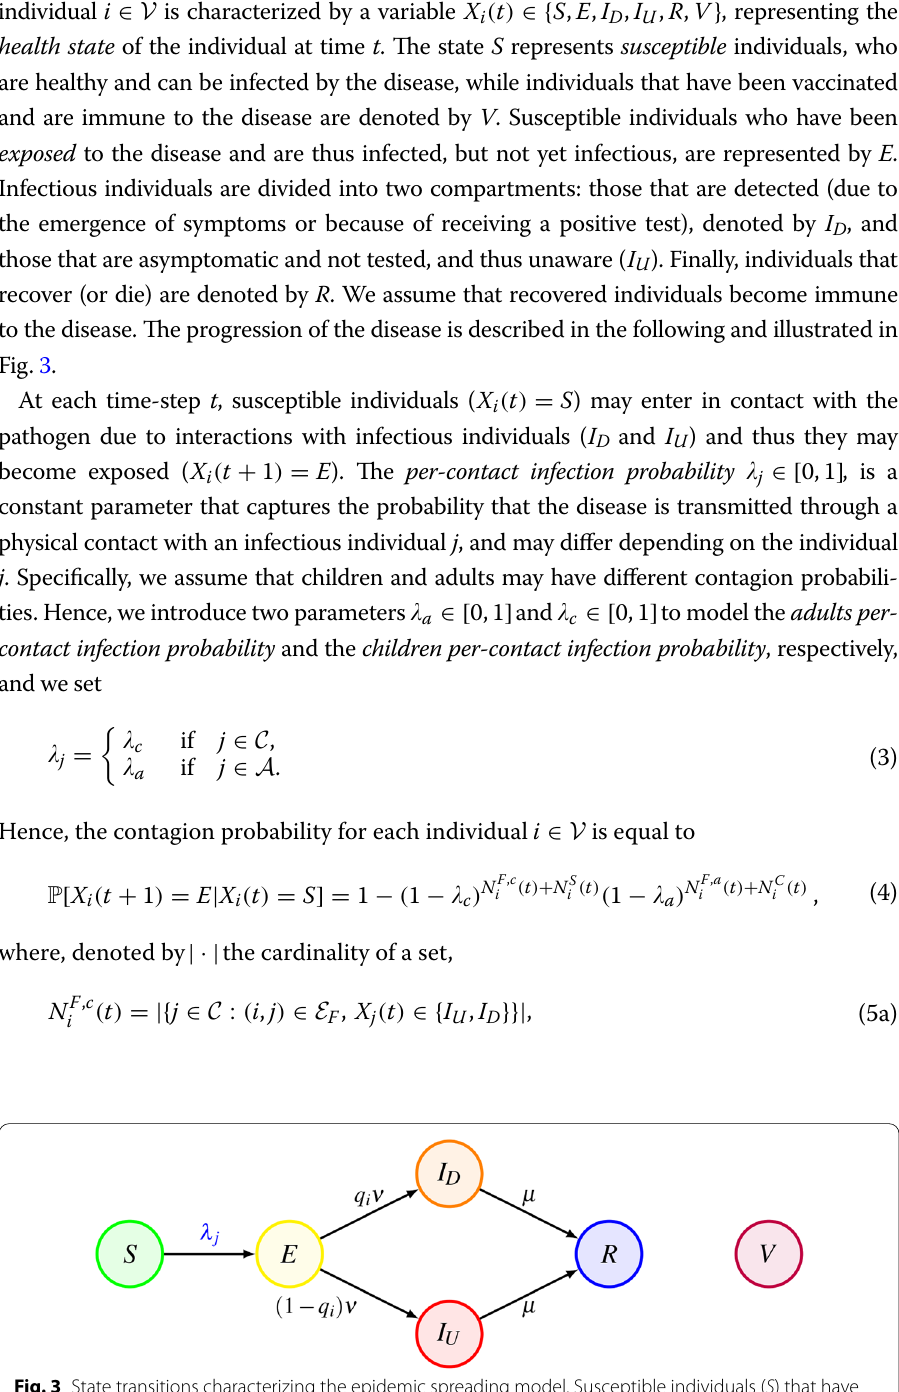
Fig. 3 State transitions characterizing the epidemic spreading model. Susceptible individuals ( S ) that have interactions with infectious individuals ( I D and I U ) may become exposed ( E ), and then infectious. Infectious individuals can be either detected ( I D ) or unaware ( I U ). Then, they may recover or die, becoming removed ( R ). Vaccinated individuals cannot contract the